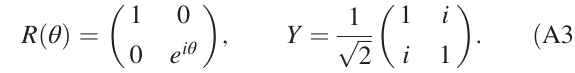
FIG. 4. Incoherent measurement circuit for U ffiffiffiffi p S ¼ Z is applied only if the imaginary part of the expectation value is H ¼ j → ih ↑ j þ j ← ih ↓ j , which transforms between the X